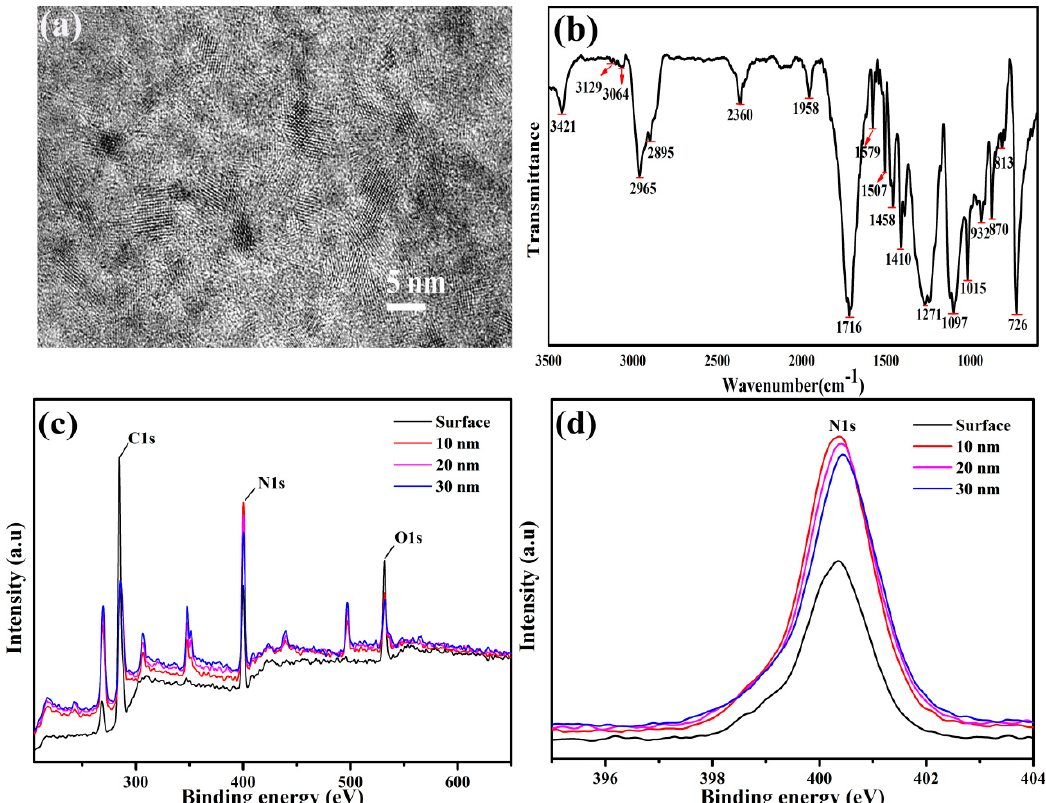
Figure 2. Characterization of N-CQDs. ( a ) TEM image of N-CQDs; ( b ) FT-IR spectrum of N-CQDs; ( c ) depth profiles of N-CQDs XPS spectra; ( d ) N1s high-resolution XPS spectra.